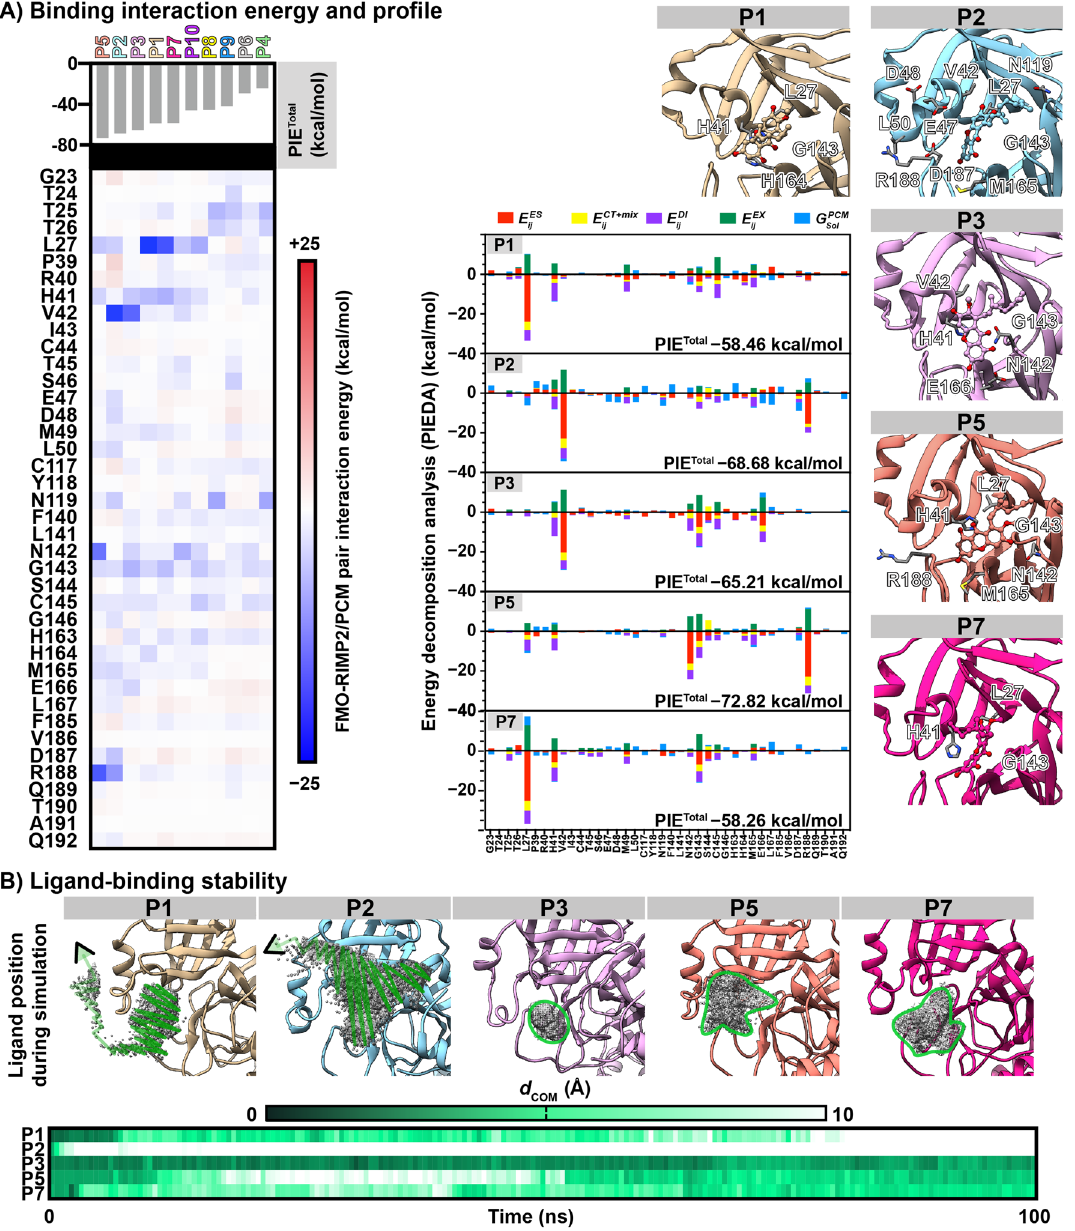
d com is plotted over